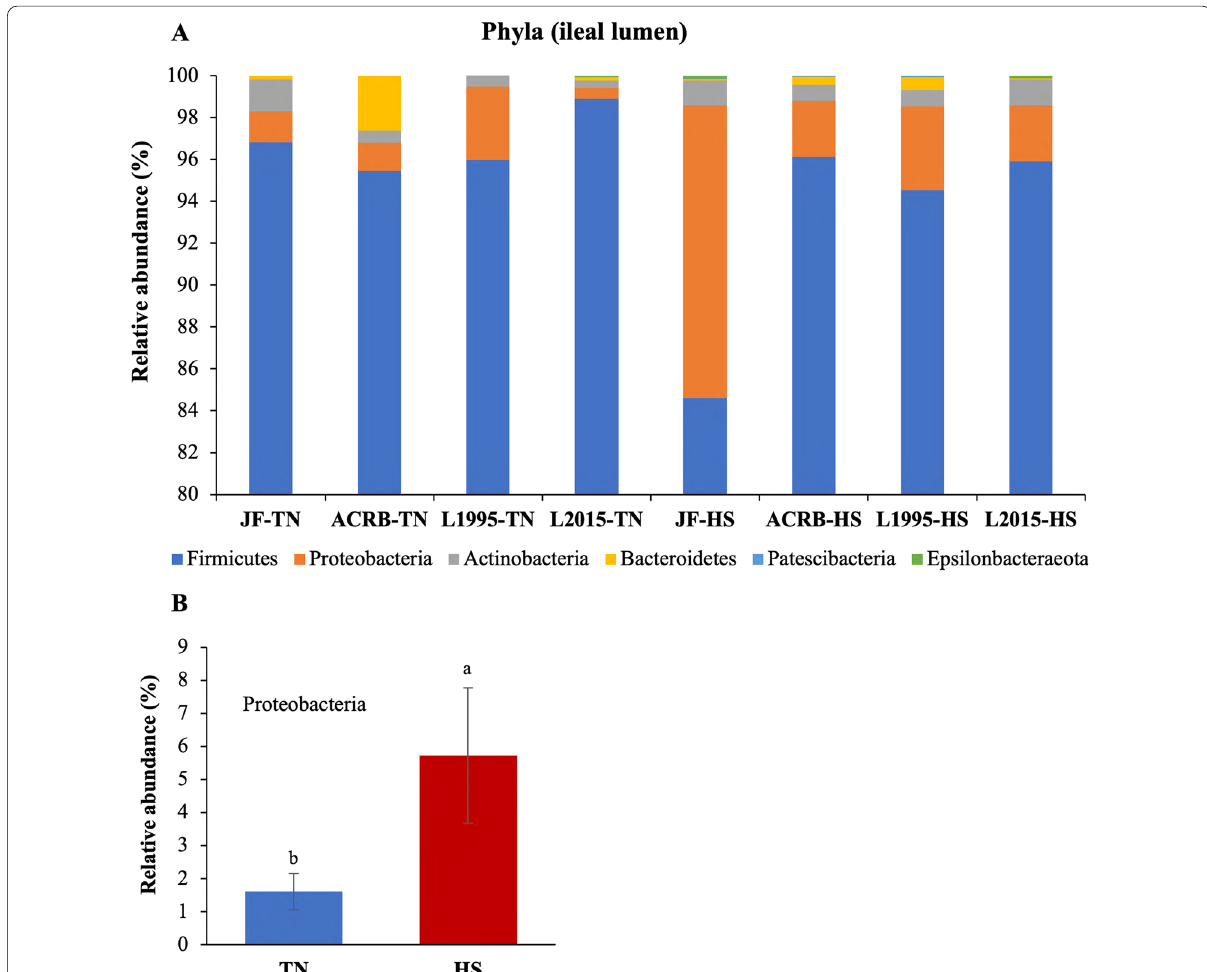
Fig. 3 Changes in relative bacterial abundance (%) in the ileal content of Jungle Fowl (JF), Athens Canadian Random Bred (ACRB), 1995 Random Bred (L1995), and 2015 Modern Random Bred (L2015) chicken lines raised under thermoneutral (TN) or heat stress (HS) condition (8 h/d; 36 °C) on d 56 at phylum level. A Taxonomic profile of ileal content microbiota. B Effect of ambient temperature on the relative abundance of Proteobacteria. Different letters denote statistically significant ( P < 0.05)